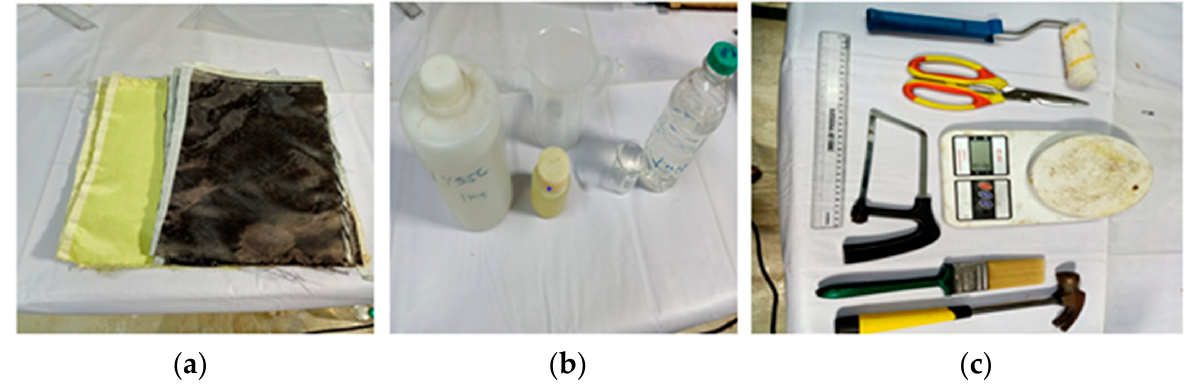
Figure 1. Reinforcements and equipment used for fabricating composites ( a ) fibers, ( b ) matrix, ( c ) tools and equipment.